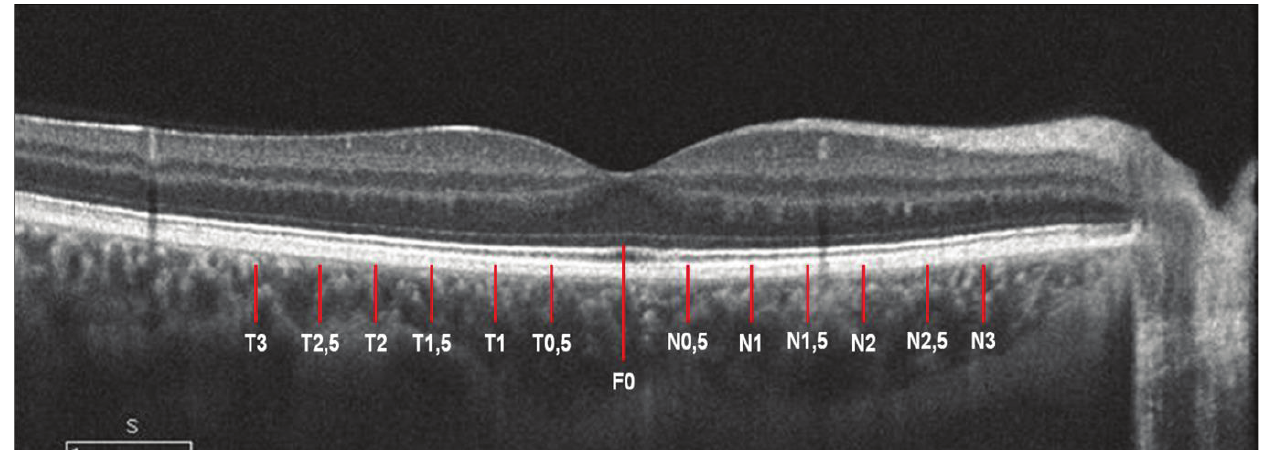
Figure 2. Representation of the 13 locations studied at intervals of 0.5 mm from the center of the fovea. T, temporal values; F0, foveal values; N, nasal